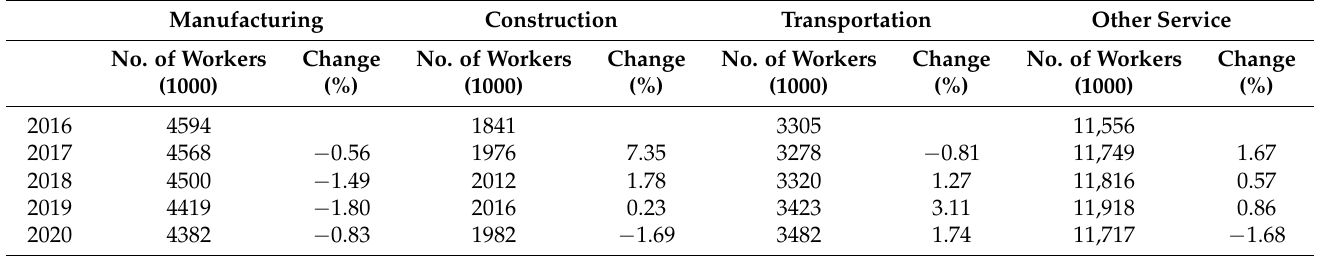
Table 9. Number of workers for industries in Korea (2016–2020). Manufacturing Construction Transportation Other